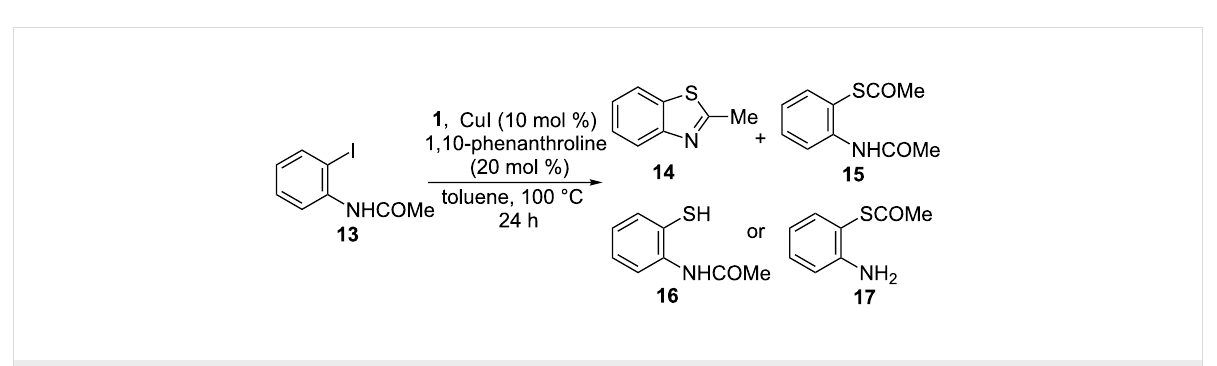
Scheme 6: Reaction of N -(2-iodophenyl)acetamide ( 13 ) with 1 .